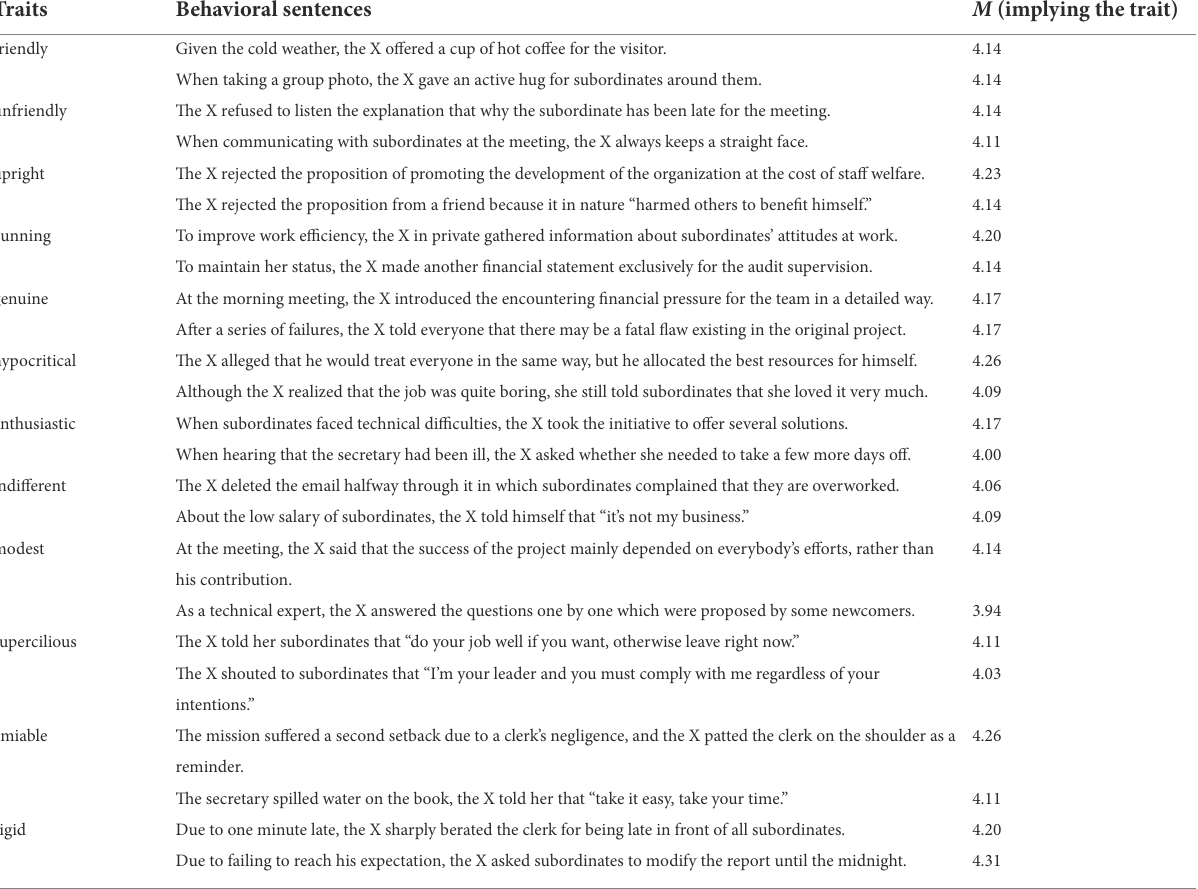
TABLE 2 The trait-implying sentences used in Study 3 and to what extent each sentence implied the corresponding trait. Traits Behavioral sentences